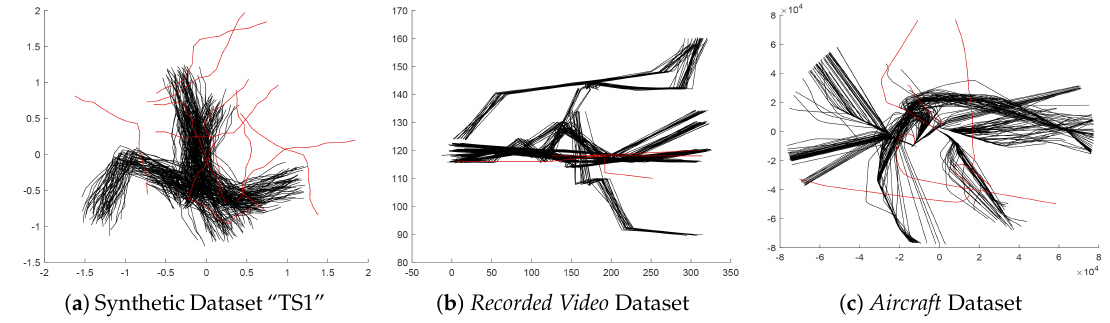
Figure 4. Plots of trajectory datasets used for the evaluation of anomaly detection measures. The trajectories colored with red are abnormal. ( a ) One dataset “TS1” from synthetic datasets. ( b ) Recorded Video trajectory Dataset. ( c ) Aircraft trajectory